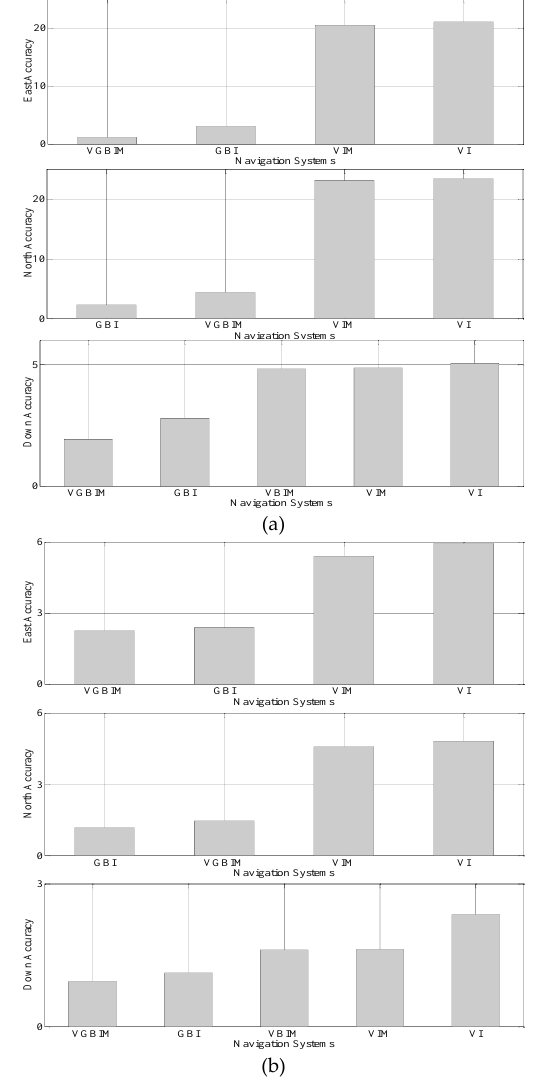
Figure 6. Multi-sensor navigation system accuracies a) MAE and b)